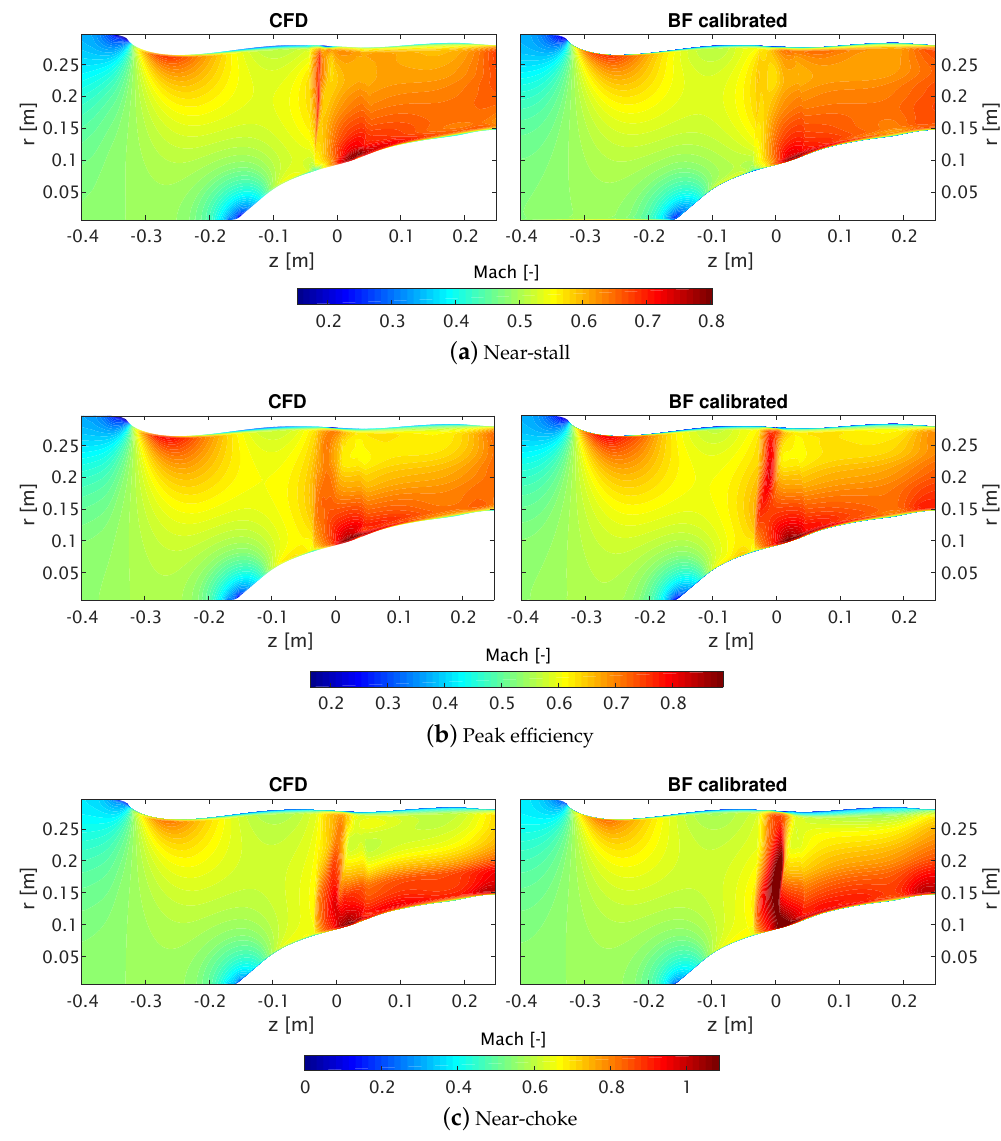
Figure 17. Mach number contours for ducted rotor-alone case at different operating